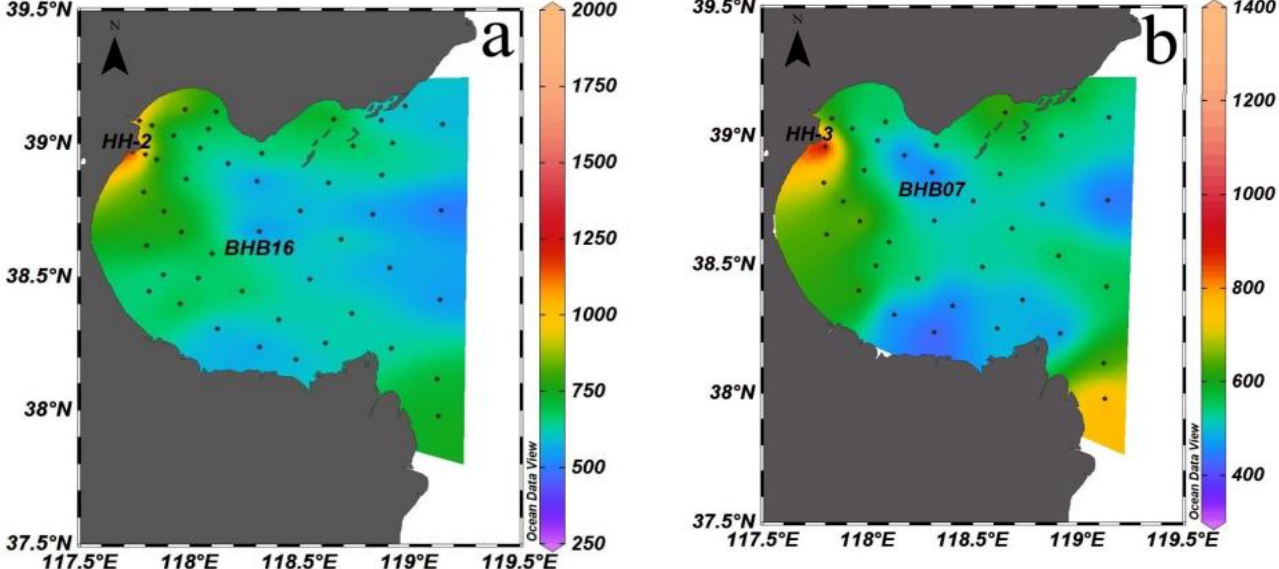
Figure 6. Horizontal distribution of p CO 2 ( µ atm) in the surface seawater ( a ) and bottom seawater ( b ) in Bohai Bay in summer 2020. The scale is 1:3,700,000. This image was created with ODV software, version 5.3.0 (Alfred Wegener Institute, Bremerhaven, Germany).